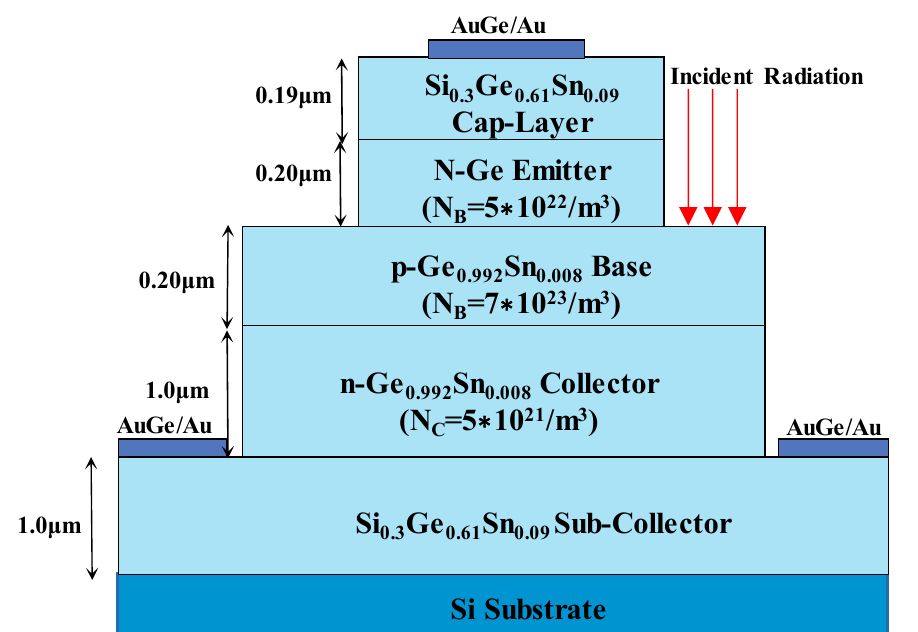
Figure 28. Schematic diagram for a front-side illuminated Ge–GeSn–GeSn hetero phototransistor